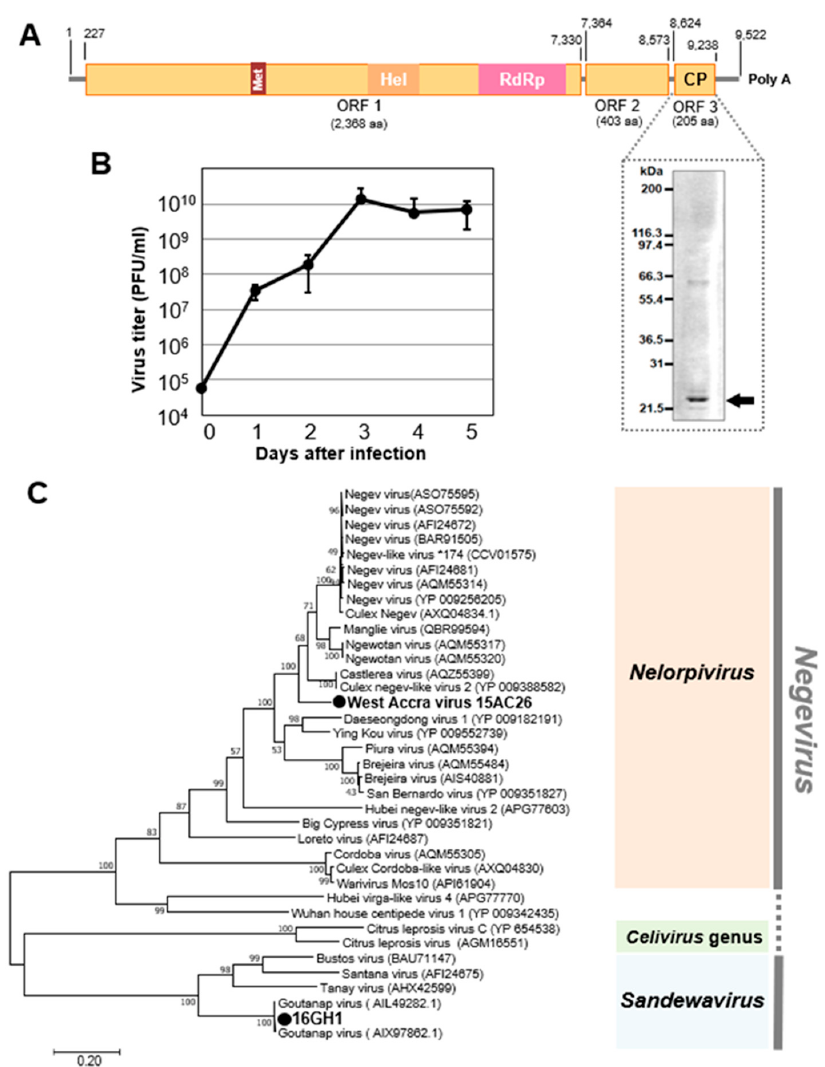
Figure 6. Genetic characterization of West Accra virus (WAV) and Goutanap virus. ( A ) Genome structure of WAV showing the representation of the capsid protein on a PAGE gel. ( B ) Growth rate of WAV in C6 / 36 cells. ( C ) Phylogenetic relationship between WAV, Nelorpivirus, and Goutanap virus (GoNV), Sandewavirus. The maximum likelihood tree of WAV and GoNV was constructed with conserved amino acid domains in genome sequences with Genbank accession numbers LC496489 and LC504569, respectively. The conserved domains were extracted using MAFFT 7 online version [27] and the Gblocks program [28]. The bootstrap support, from 1000 bootstrap replicates, are indicated by values on the branches.